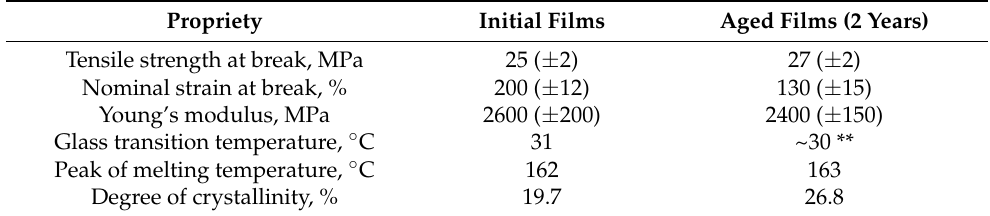
Table 7. Comparative mechanical * and thermal characterizations of PLA/0.3J–AII–10TBC films (120 µ m thickness) before and after 2 years aging.